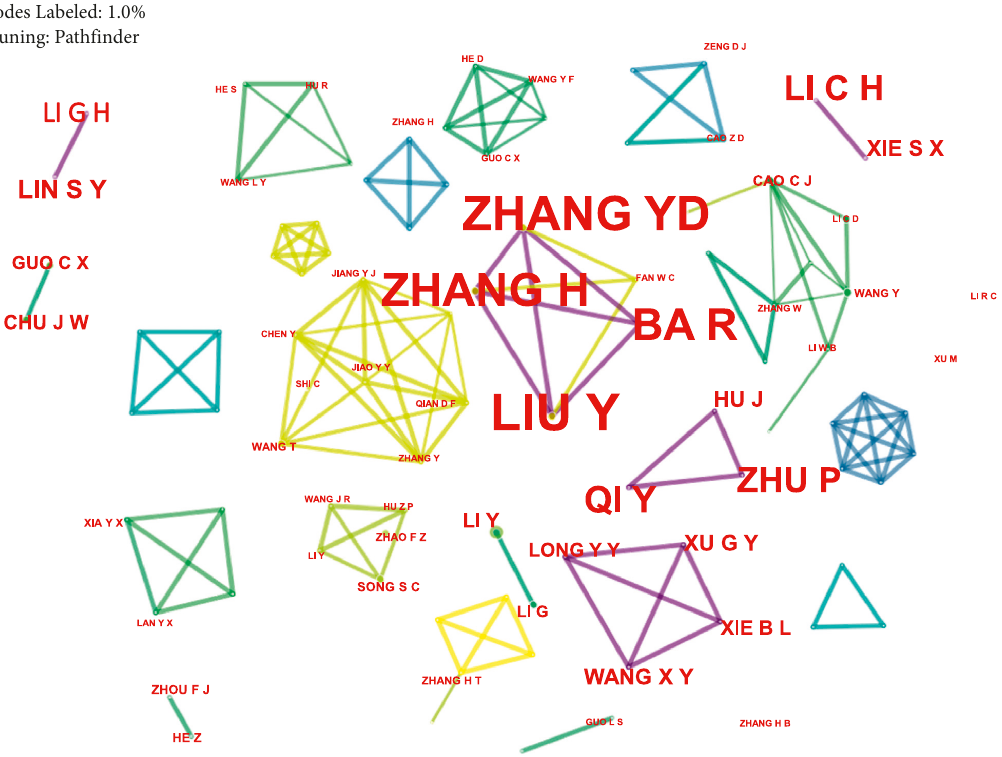
Figure 9: Authors’ cooperation network of Chinese DEM